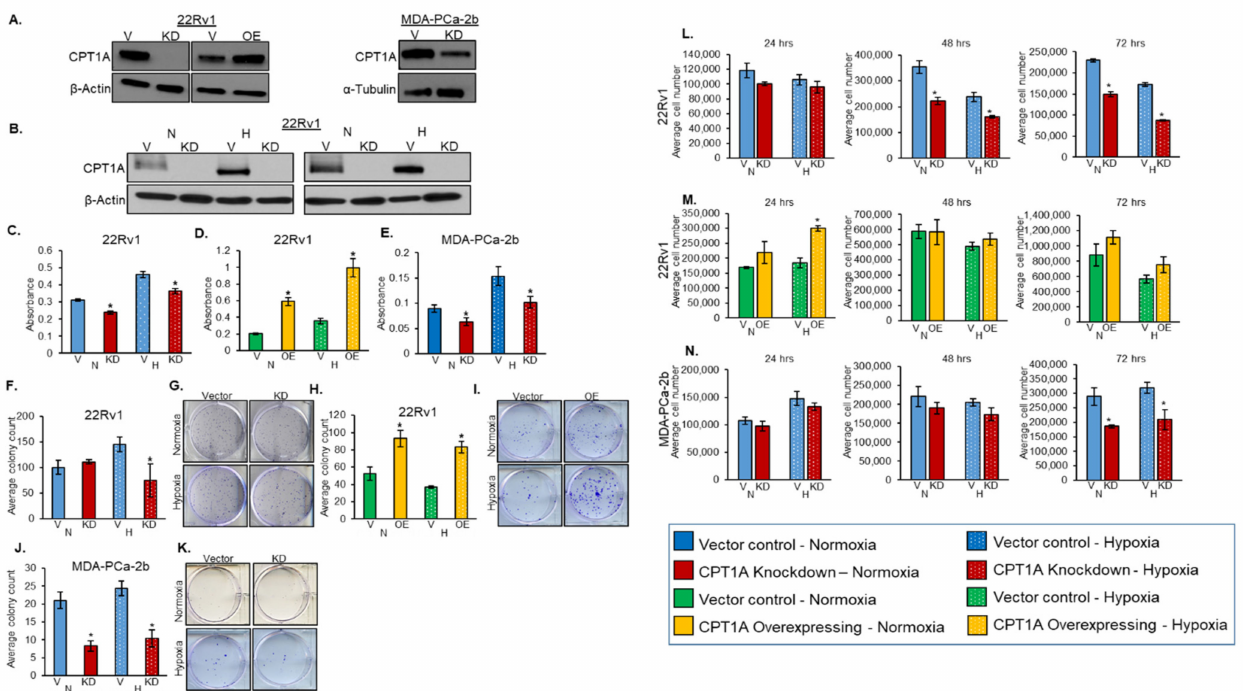
Figure 1. Role of CPT1A in regulating the PCa cell survival, proliferation, and colony formation under hypoxic conditions. ( A ) CPT1A expression was assessed in PCa cells with stable knockdown (KD) or overexpression (OE) of this protein compared to respective vector control cells (V) by Western blotting. The membranes were stripped and re-probed for β -actin or α -tubulin. CPT1A expression was assessed in 22Rv1 cells with stable knockdown grown under 6 and 48 h of hypoxic conditions ( B ). Cells were grown under normoxic (~21% O 2 solid bars, N) or hypoxic (1% O 2 , dotted bars, H) conditions for 48 h, and cell survival was assessed by MTT assay in 22Rv1 cells ( C , D ) (* p < 0.001) and MDA-PCa-2b cells ( E )(* p < 0.02) cells with stable knockdown (KD, red) or overexpression (OE, yellow) of CPT1A compared to their corresponding vector controls (V, blue, vector control for CPT1A knockdown cells) (V, green, vector control for CPT1A overexpressing cells). Colony number was assessed in 22Rv1 cells with stable knockdown of CPT1A compared to vector control cells under normoxia or hypoxia. ( F , G ) Colony number was assessed in 22Rv1 cells with stable overexpression of CPT1A (OE) compared to vector control cells grown under normoxia or hypoxia (normoxia * p < 0.015 and hypoxia * p < 0.007). ( H , I ) Colony number was assessed in MDA-PCa-2b cells with stable knockdown of CPT1A (KD) compared to vector control cells grown under normoxic or hypoxic conditions (normoxia * p < 0.011 and hypoxia * p < 0.006). ( J , K ) Average cell number (total cell count) was determined under normoxic or hypoxic conditions for 24, 48, and 72 h using trypan blue exclusion assay in 22Rv1 cells with stable knockdown of CPT1A (KD) compared to vector control cells (48 h * p < 0.003, * p < 0.002; 72 h * p < 0.01) ( L ), stable overexpression of CPT1A (OE) compared to vector control cells (* p < 0.002) ( M ), and MDA-PCa-2b with stable knockdown of CPT1A (KD) compared to vector control cells ( N ). Results are representative of average ± SEM. Experiments were performed in triplicate. Figure S1: Full blots for Figure 1A- left panel are shown in Figure S1 and full blots for Figure 1A- right panel are shown in Figure